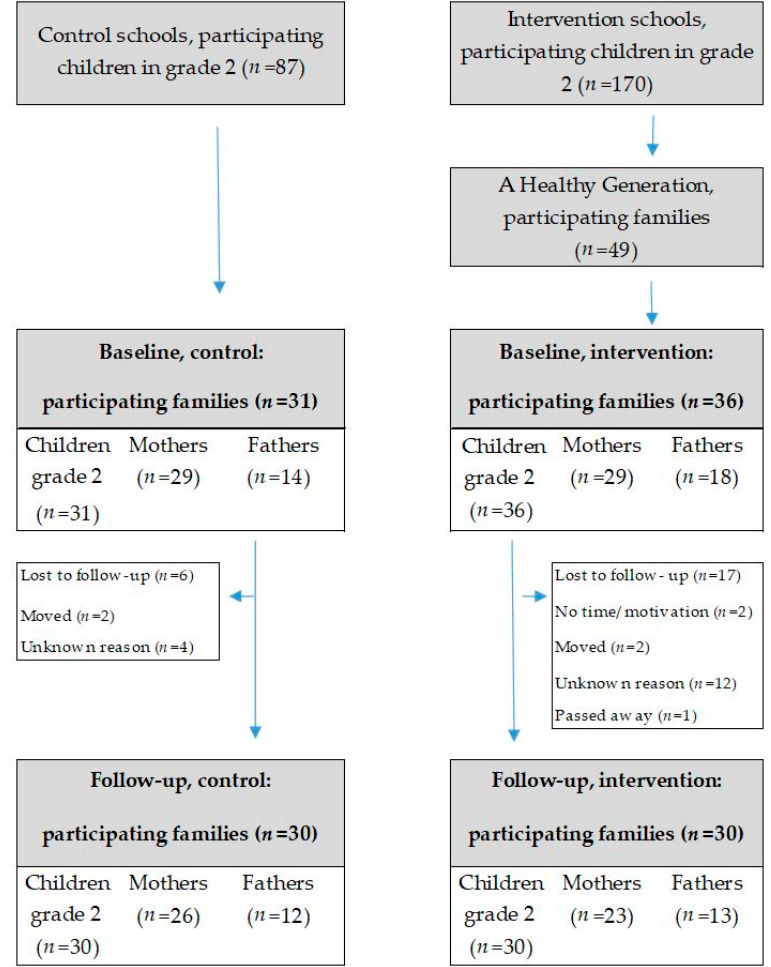
Figure 1. Participant flow diagram.